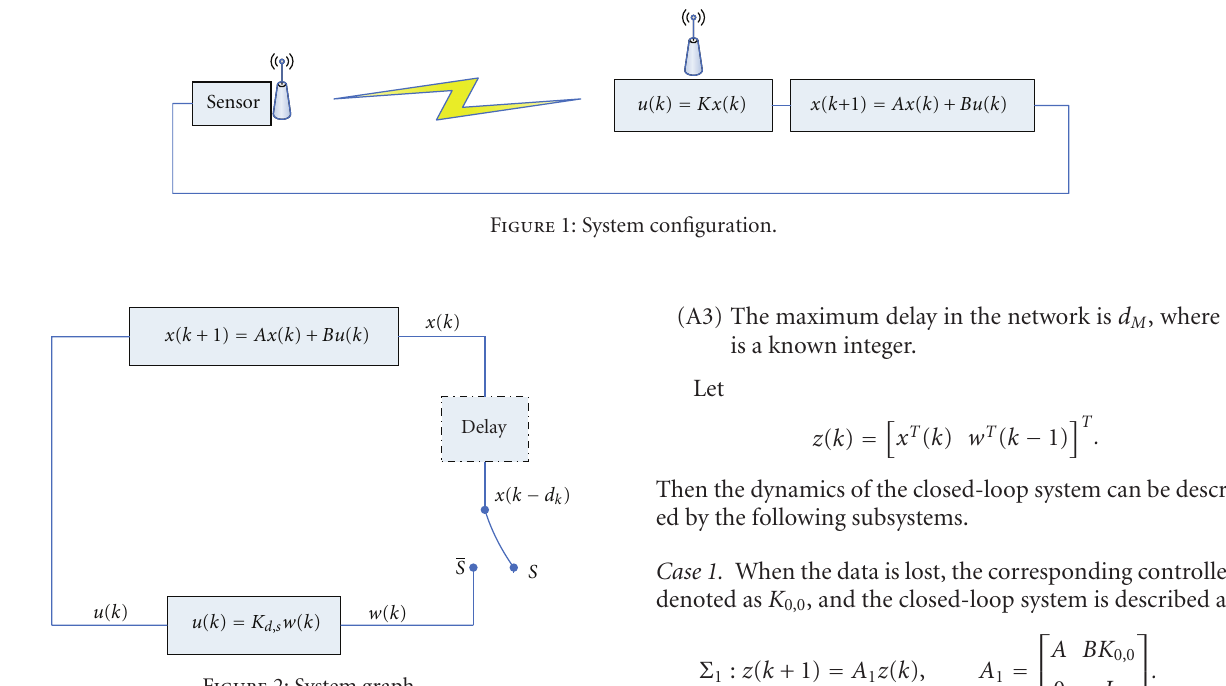
Figure 2: System